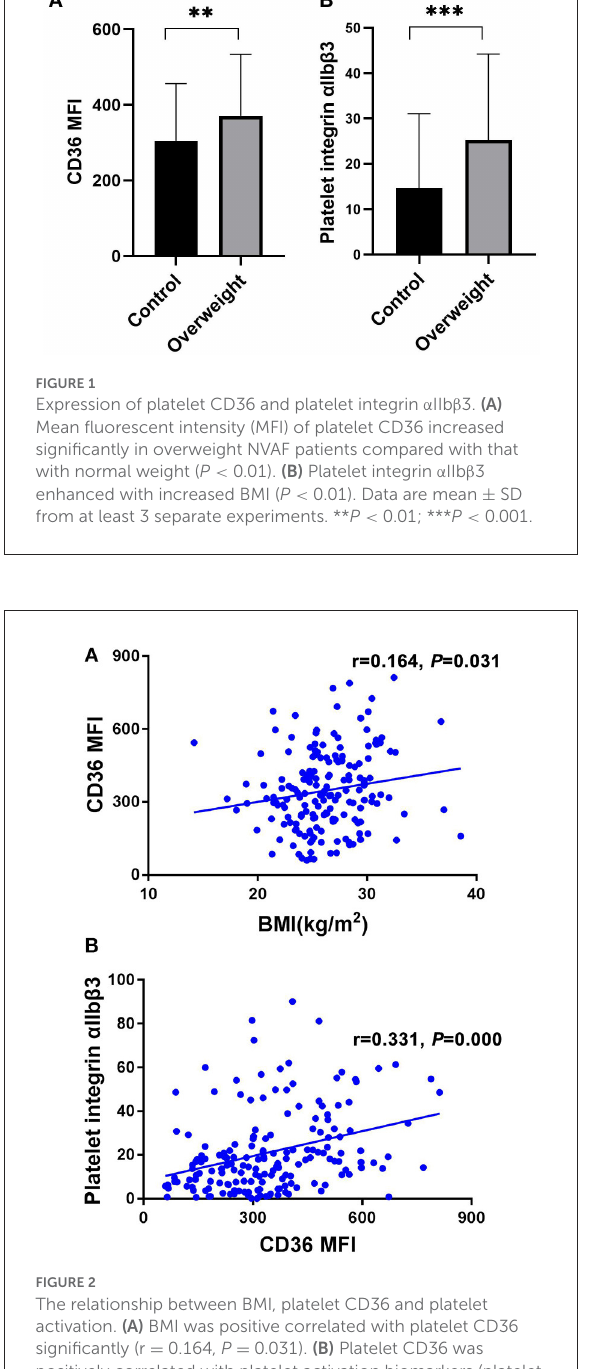
= 0.286, P = 0.001) and BMI ( β = 0.175, P = 0.036) were